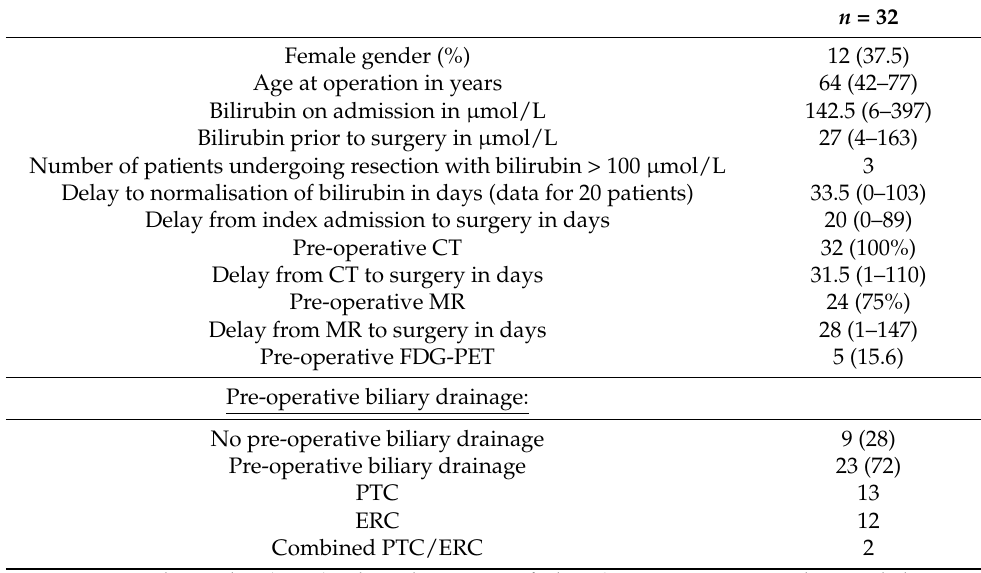
Table 1. Admission assessment and pre-operative